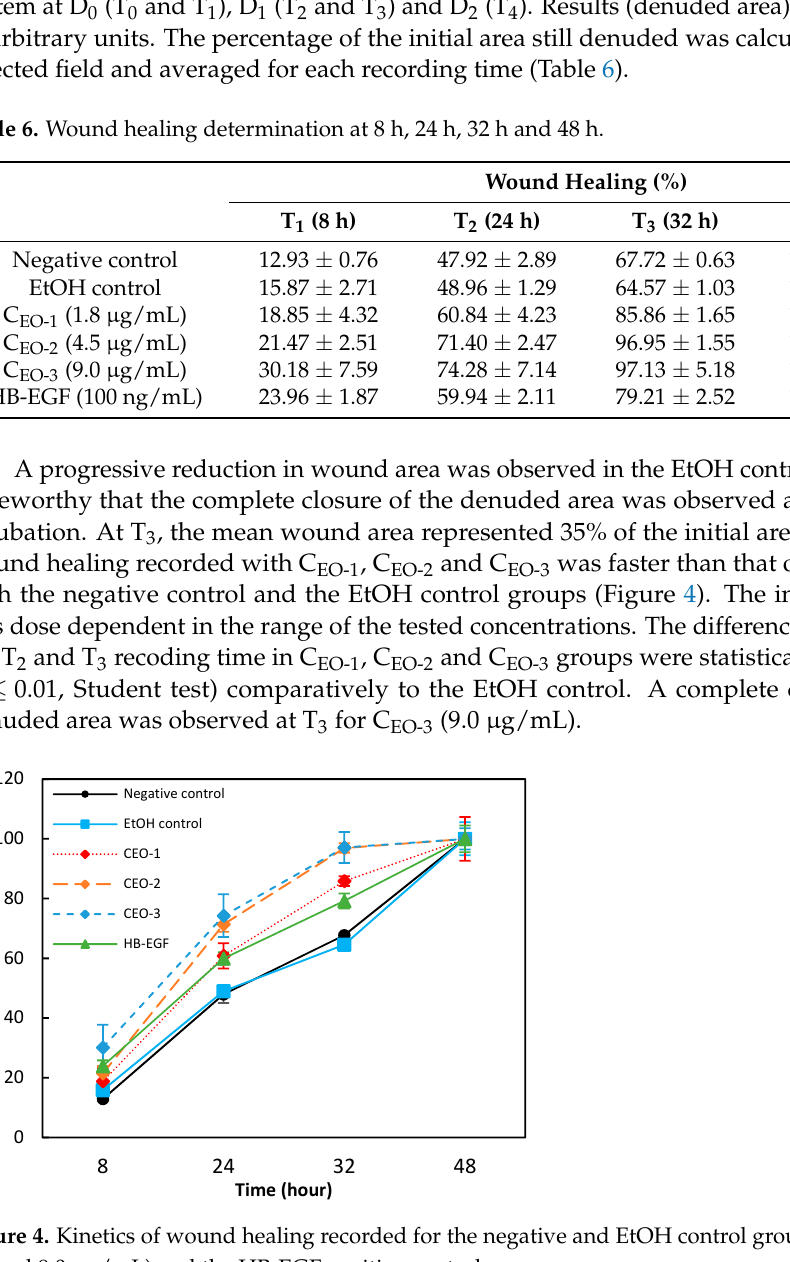
Figure 4. Kinetics of wound healing recorded for the negative and EtOH control groups, the EO (1.8, 4.5 and 9.0 μ g/mL) and the HB-EGF positive control.